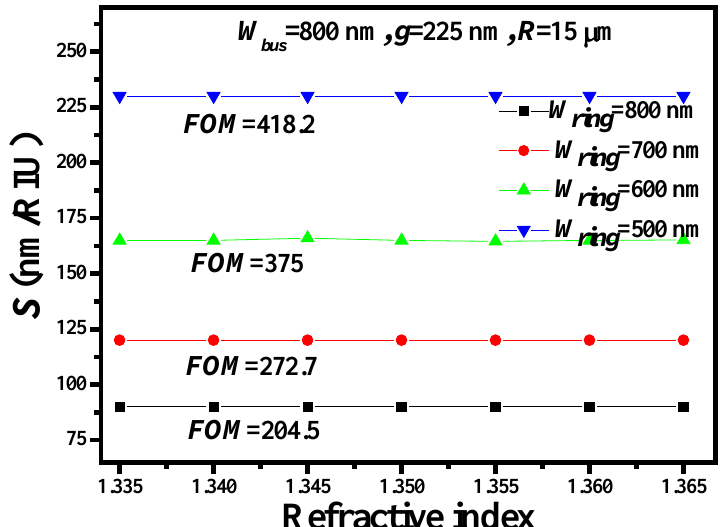
Figure 13. Evaluation of S and FOM based on W ring . The remaining geometric parameters such as W bus , R and g were fixed at 800 nm, 15 µm and 225 nm, respectively.